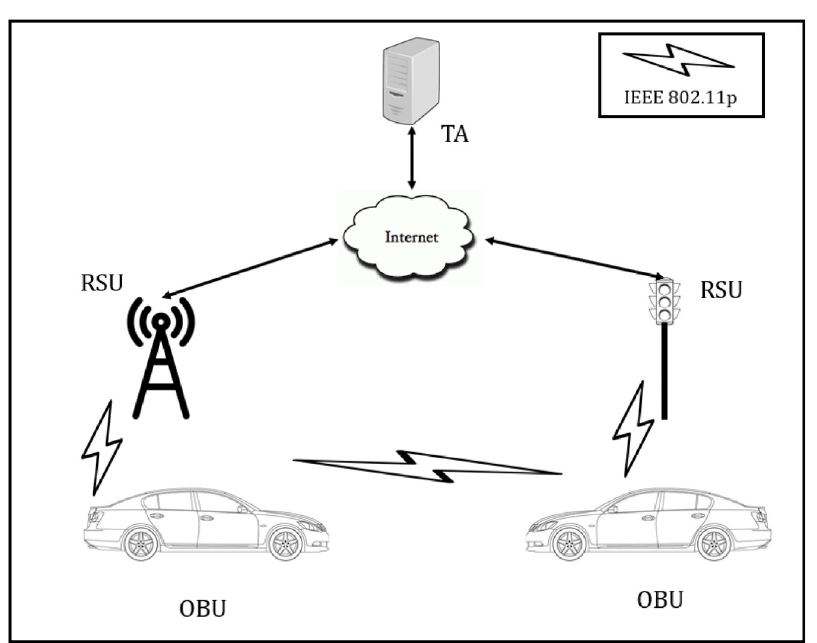
Fig 1. The topology of